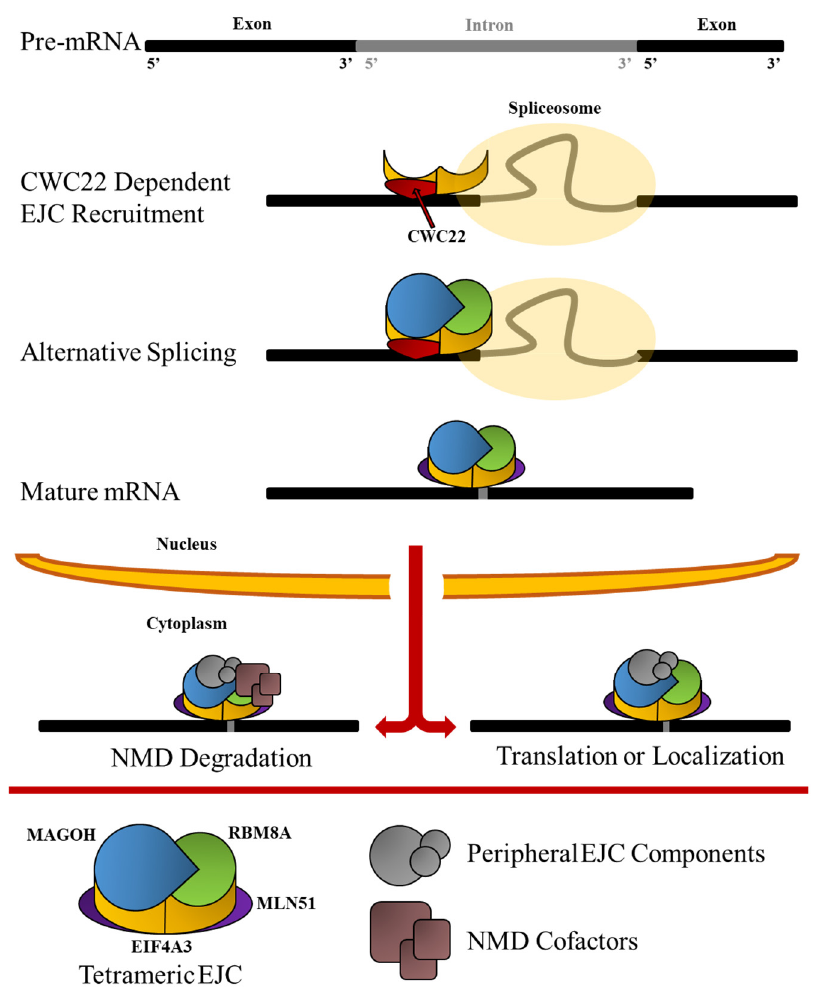
Figure 1. Graphical representation of the formation and function of the EJC. Splicing factor CWC22 bridges spliceosome activity to EJC formation by recruitment of EJC core component EIF4A3. Spliceosome formation is completed concurrently with immature EJC formation as the MAGOH-RBM8A heterodimer binds to EIF4A3. After splicing, MLN51 completes the mature tetrameric EJC core, and the EJC-associated mRNA is exported from the nucleus to the cytoplasm. Peripheral EJC components and NMD cofactors mediate the differentially factor-specific progression to nonsense mediated decay or downstream pathways further in the cytoplasm including translation and mRNA localization.